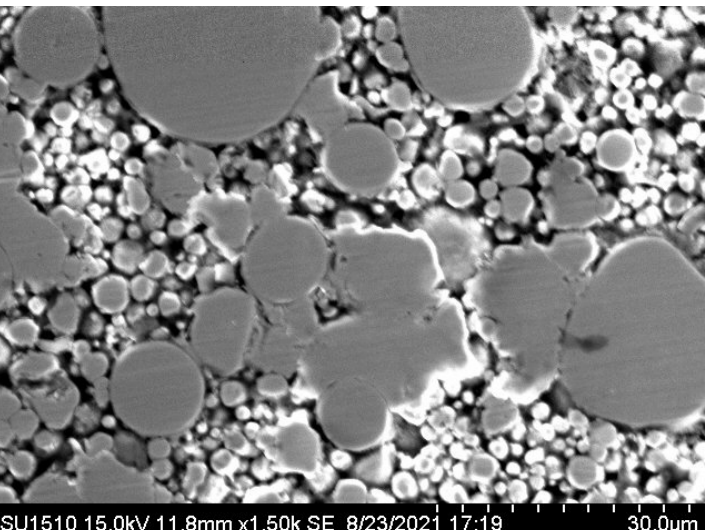
Figure 5. Variation of the compaction densities of the compacted bodies after heat treatment with different powder mixing ratios.